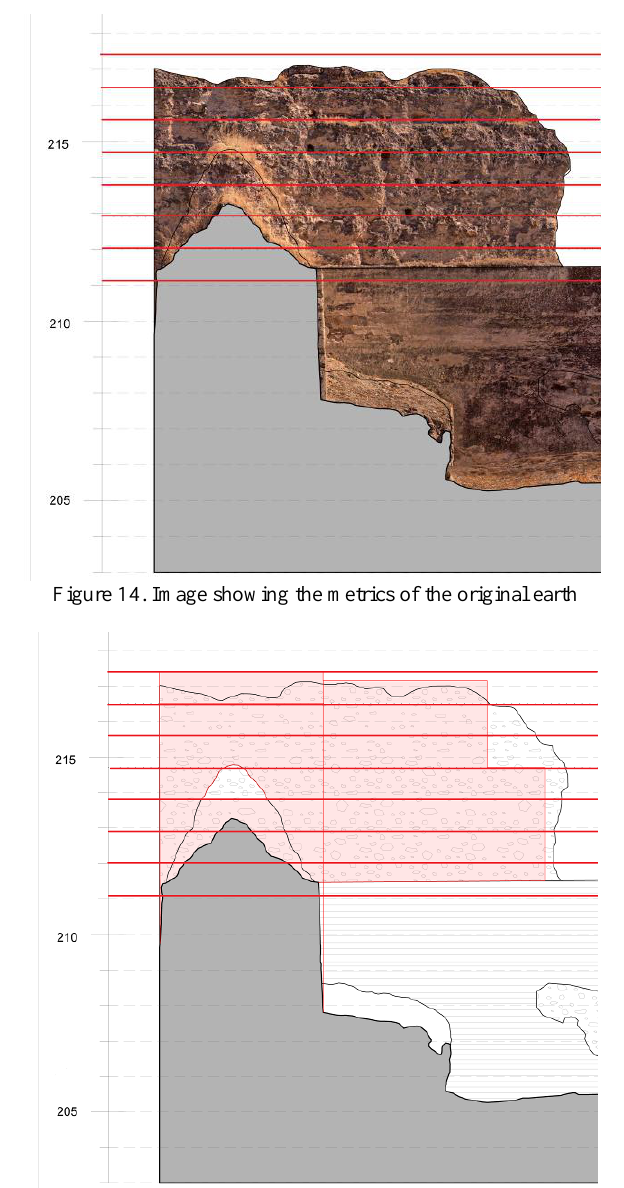
Figure 15. New intervention